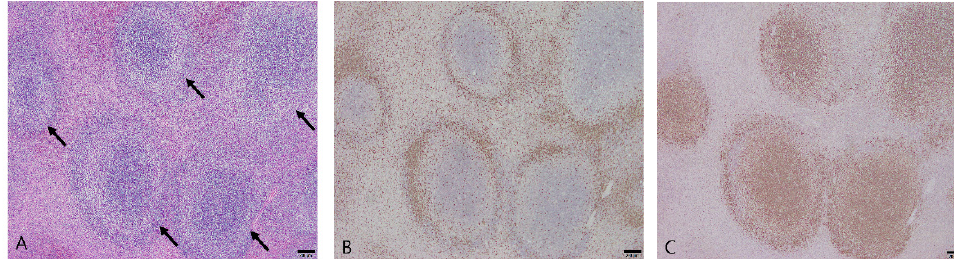
Figure 1. Nodular hyperplasia in the spleen of a dog. ( A ) The proliferating lymphoid follicles were clearly separated from each other (arrows). Hematoxylin and eosin (H&E) at 40 × magnification. Scale bar = 200 µ m. ( B ) Immunohistochemical staining for CD3 with Mayer’s hematoxylin counter- stain. CD3 was expressed at the periphery of the follicles. 40 × magnification. Scale bar = 200 µ m. ( C ) Immunohistochemical staining for PAX5 with Mayer’s hematoxylin counterstain. PAX5 was expressed within the follicles. 40 × magnification. Scale bar = 200 µ